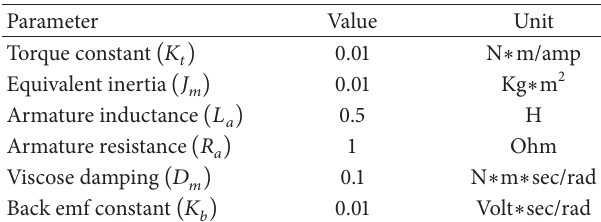
Table 1: DC servomotor